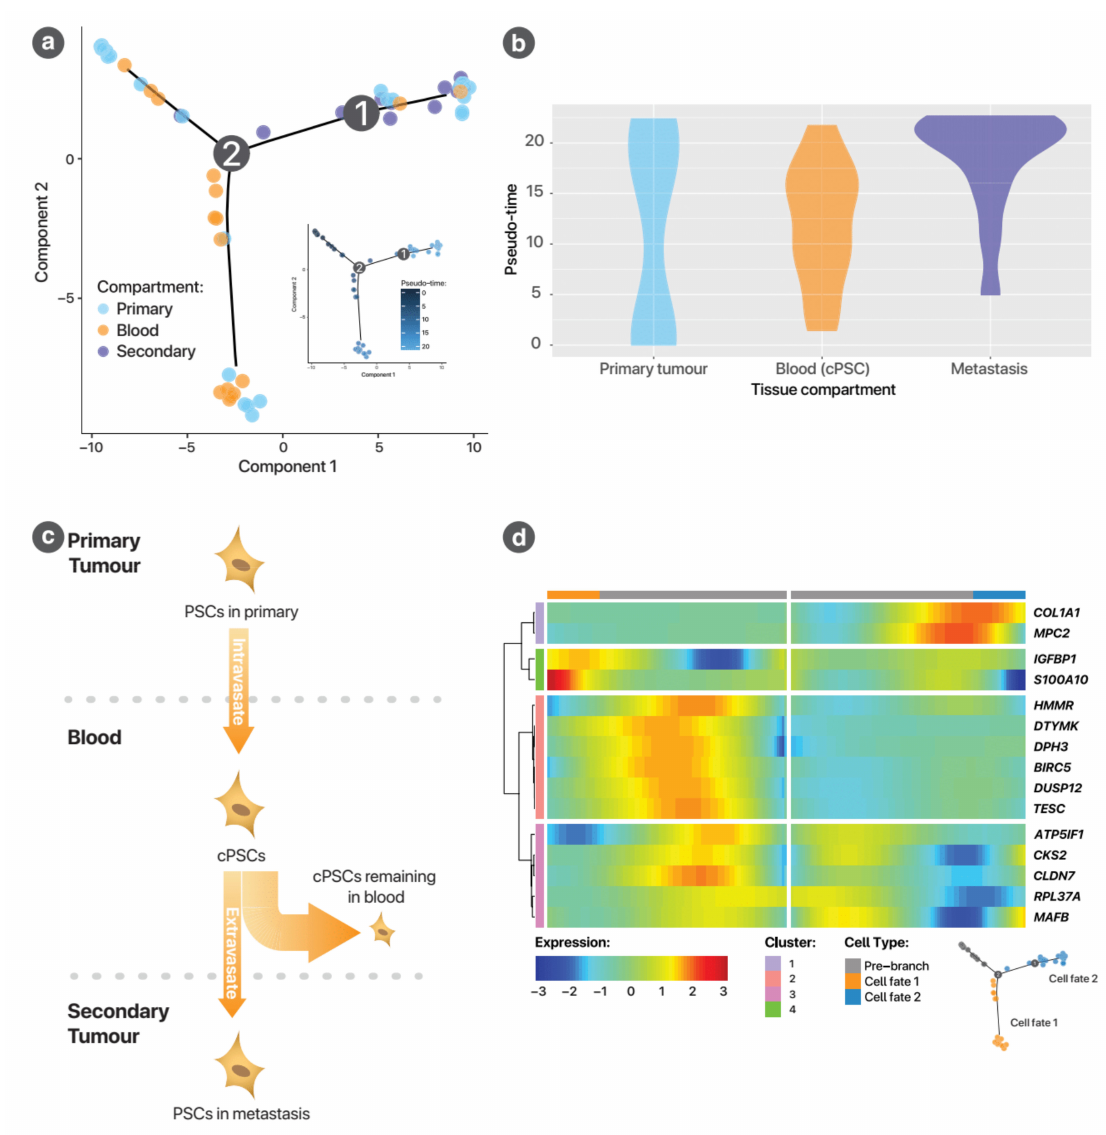
Figure 6. Trajectory analysis of PSC development. ( a ) This shows the PSC development trajectory, with cells coloured to reflect the sample of origin, demonstrated a bifurcated trajectory, with one major branch point (vertex 2). The inset figure shows the same trajectory, with cells shaded by pseudo-time. At the origin of the trajectory, PSCs from the primary cancer predominate. The two limbs arising from vertex 2 lead to different cell fates: one dominated by circulating PSCs (lower limb) and one by PSCs in the metastasis (right limb). ( b ) Pseudo-temporal changes in cell numbers by compartment. These violin plots present the changes in the numbers of cells in each of the tissue compartments over pseudo-time. The most important observation here is the relative timing of the peaks of cell numbers in the different compartments: first primary cancer, then blood and finally metastasis. This is consistent with the biology of the metastatic process. Note that the width of the violin plots only reflects relative cell numbers within the compartment, not between compartments. The scaling of the violin is such that the total area under the curve is the same for each violin (i.e., it is a probability density function for that sample). ( c ) This panel shows an interpretation of the PSC trajectory. PSCs intravasate into the blood to form cPSCs. A small proportion of these circulating PSCs extravasate and incorporate into metastatic nodules (or form metastatic niches). The remainder remain in the circulation. This explains the bifurcated trajectory. ( d ) This heatmap describes changes in gene expression over pseudo-time as cells pass through branch point 2. The centre of the heatmap represents the pre-branch trajectory, which is signified by the grey bar above and the grey cells in the legend trajectory map below. The two sides of the heatmap represent the two cell fates (Cell fate 1, predominated by cPSCs, in orange; and Cell fate 2, predominated by metastatic PSCs, in blue). Genes are clustered by k -means